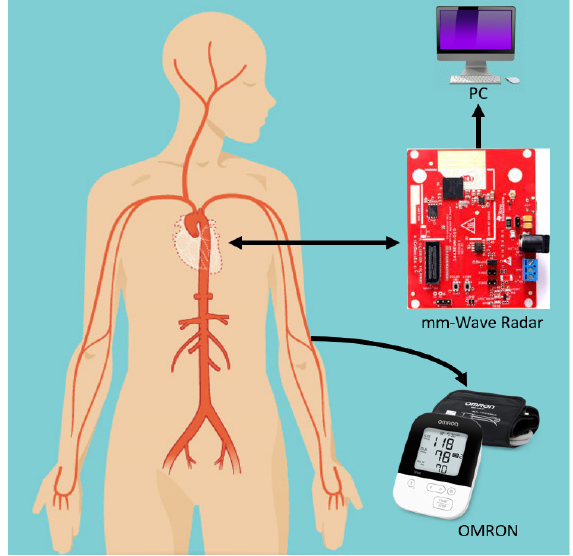
Figure 1. Schematic of the proposed mm-wave radar system: an mm-wave radar is fixed at front of the subject while an Omron sphygmomanometer is attached, which simultaneously extracts pulse readings for verification. The radar data are recorded on a PC through a USB connection.